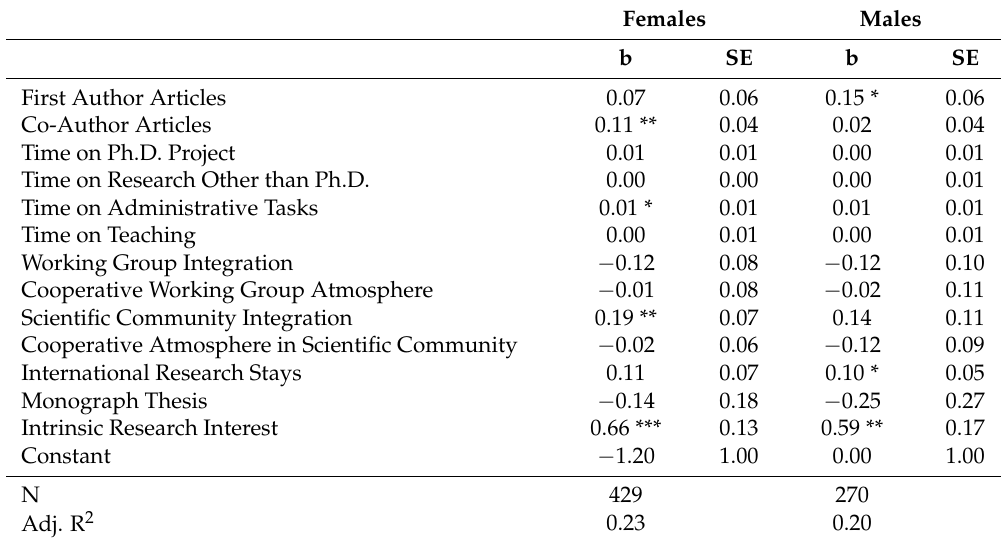
Table 4. Factors Associated with Academic Career Intentions for Females and